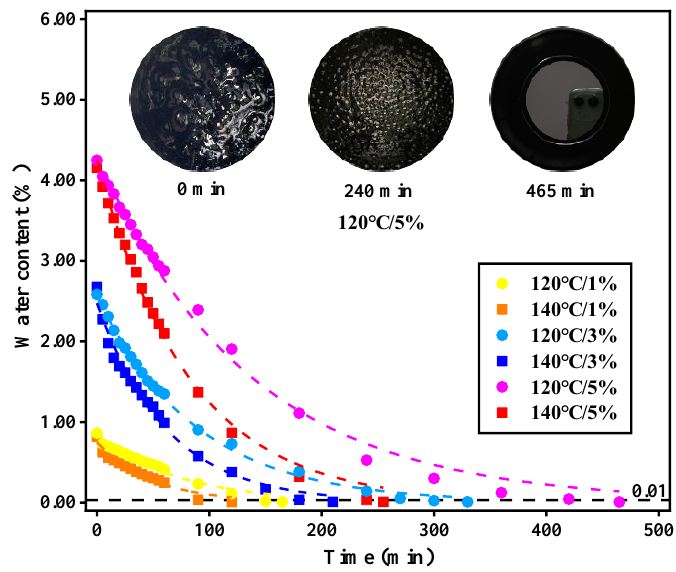
Figure 2. Evolutions of residual water content of the foamed asphalt over time.